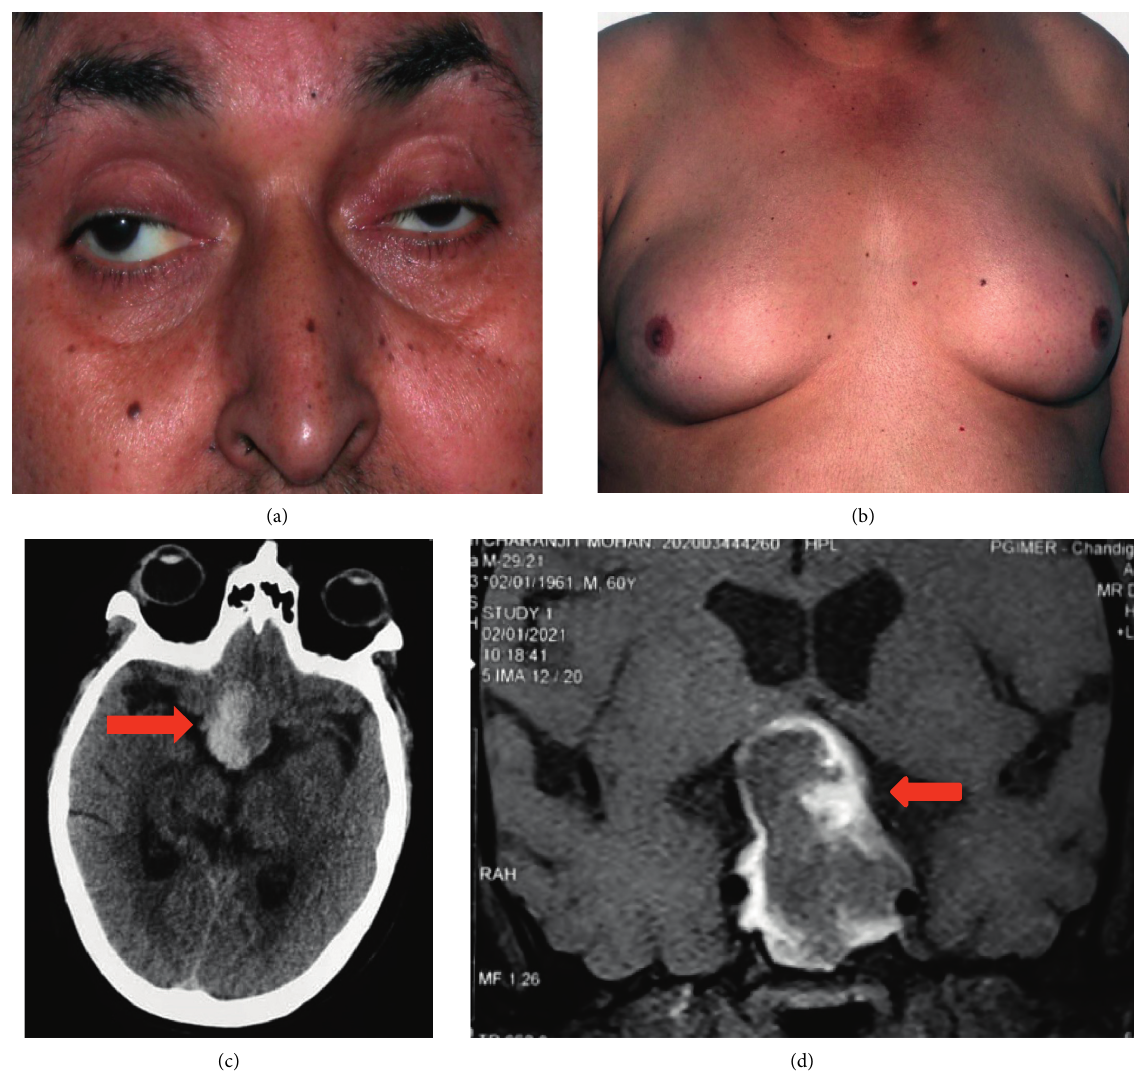
Figure 1: A 60-year-old male presented with sudden-onset severe headache and vision loss. (a) Bilateral ptosis and abducted right eye; (b) bilateral gynaecomastia; (c) axial NCCT head demonstrating a large sellar mass with areas of hyperdensity within suggestive of acute hemorrhage; and (d) coronal noncontrast T1-weighted MRI sellar demonstrating a 3.1 × 2.7 × 4.1 cm pituitary adenoma with peripheral T1 hyperintensity suggestive of acute